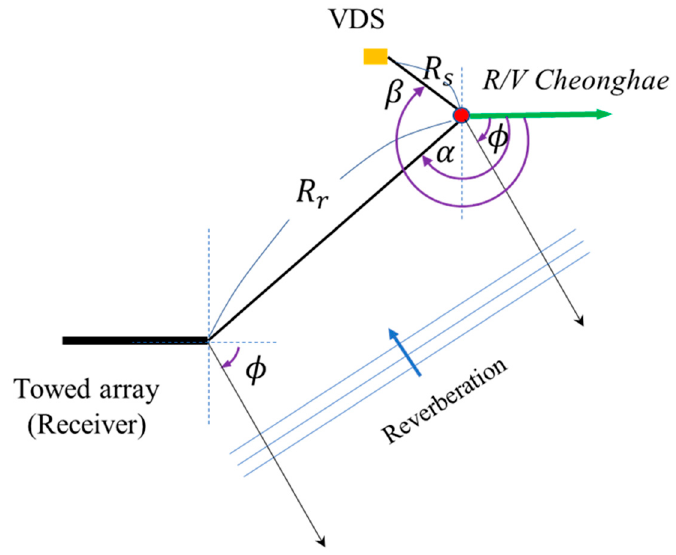
Figure 10. Bistatic configuration of active towed array system in this experiment ( α : azimuth angle of towed array, β : azimuth angle of VDS, γ : bistatic angle, Rr: distance between ship and towed array, Rs: distance between ship and VDS, φ : steering azimuth angle).